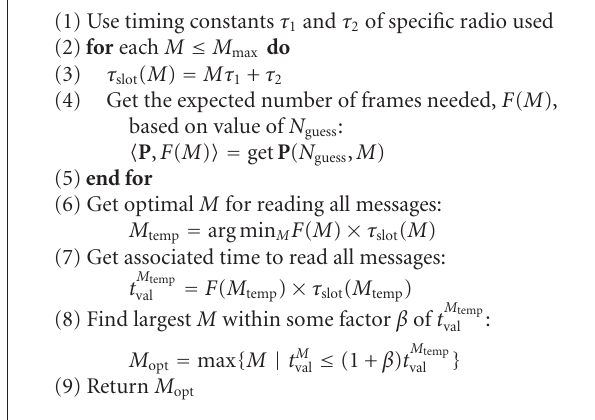
Algorithm 2: Procedure get P ( n , M ). Algorithm 3: Procedure get M ( N